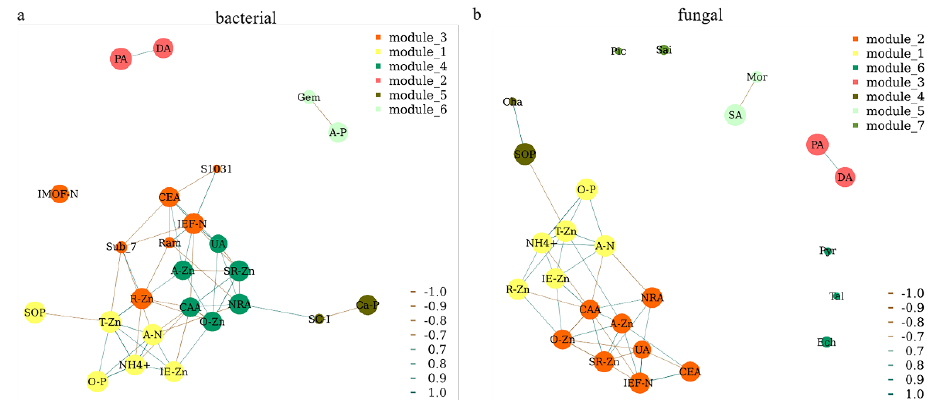
Figure 8. Network analysis of the bacterial ( a ) and fungal ( b ) genera, enzyme activities, and different forms of Zn, N, and P in rice rhizosphere soil. A correlation coefficient threshold of Spearman’s r s ≥ 0.9 with p value ≤ 0.05 was used. A-N, alkali-hydrolyzed nitrogen; A-P, available phosphorus; A-Zn, available zinc; IE-Zn, acid extraction zinc; R-Zn, reducible zinc; O-Zn, oxidizable zinc; SR-Zn, solid residue zinc; T-Zn, total zinc; IMOF-N, iron-manganese oxide nitrogen; IEF-N, ion exchanged nitrogen; NH 4 + , ammonium; O-P, occluded phosphorus; Ca-P, calcium bound phosphorus; SOP, soil organic phosphorus; PA, protease activity; UA, urease activity; DA, dehydrogenase activity; SA, surase activity; CAA, catalase activity; NRA, nitrate reductase activity; CEA, cellulose activity; Gem, Gemmatimonas ; Sub_7, Subgroup_7; Ram, Ramlibacter ; SC-I, SC-I-84; S1031, SBR1031; Mor, Mortierella ; Ech, Echria ; Sai, Saitozyma ; Cha, Chaetomium ; Pyr, Pyrenochaetopsis ; Ser, Serendipita